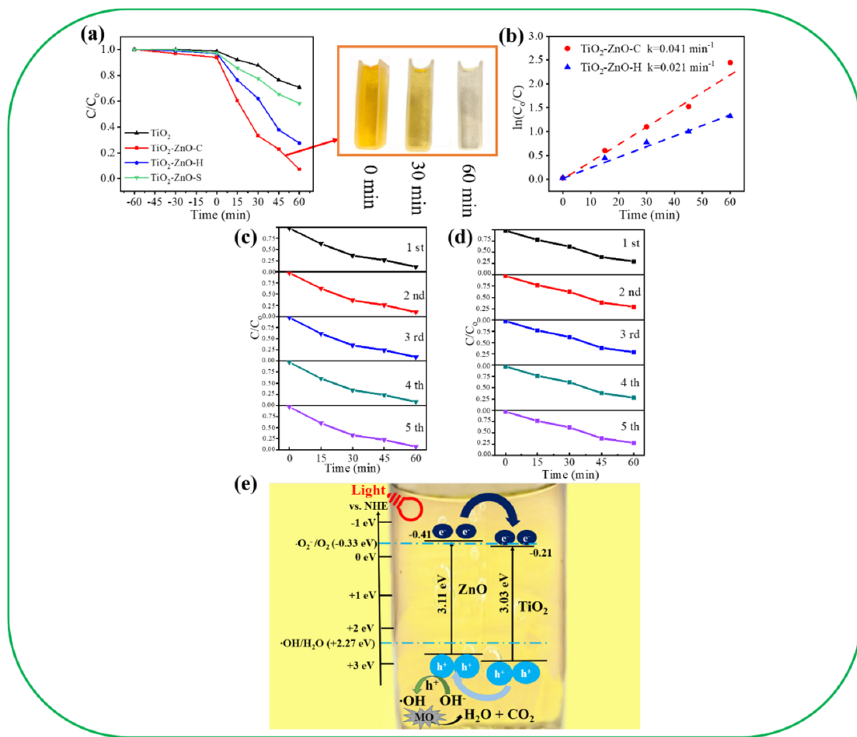
Figure 9. ( a ) Photodegradation level of the methyl orange (MO) solution in the presence of various samples. The inset show the discoloration of the MO solution containing the TiO 2 –ZnO–C under various irradiation durations. ( b ) Kinetic reaction rate k for the degradation of the MO solution with the TiO 2 –ZnO–C, and TiO 2 –ZnO–H. ( c ) Recycling photodegradation tests of the MO solution containing TiO 2 –ZnO–C. ( d ) Recycling photodegradation tests of the MO solution containing TiO 2 –ZnO–H. ( e ) A possible band alignment of the TiO 2 –ZnO and photodegradation reaction of the TiO 2 –ZnO towards the MO